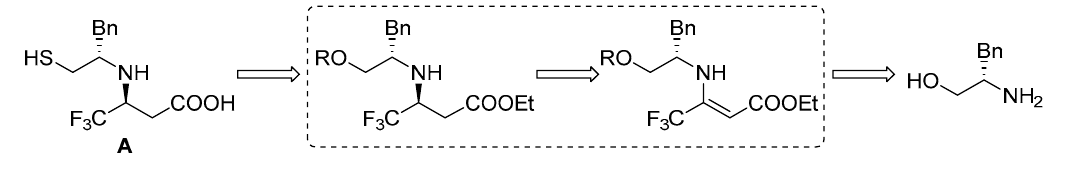
Scheme 1. Retrosynthetic approach to A.